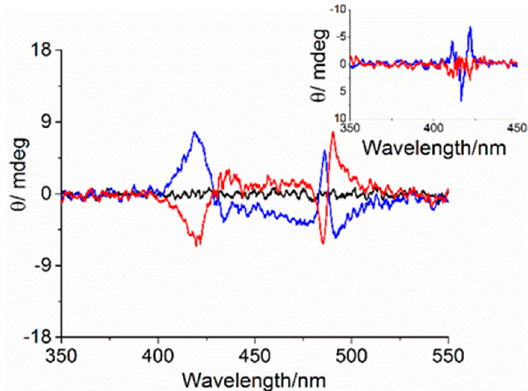
Figure 2. Circular dichroism (CD) spectra of Au 10 in aqueous solution (black line), Au 10 @TPPS nanohybrid assemblies for L -(blue line) and D -histidine (red line) before (inset) and 1 h after HCl addition. ([Au 10 ] = 125 μ M, [TPPS] = 5 μ M, pH 2).